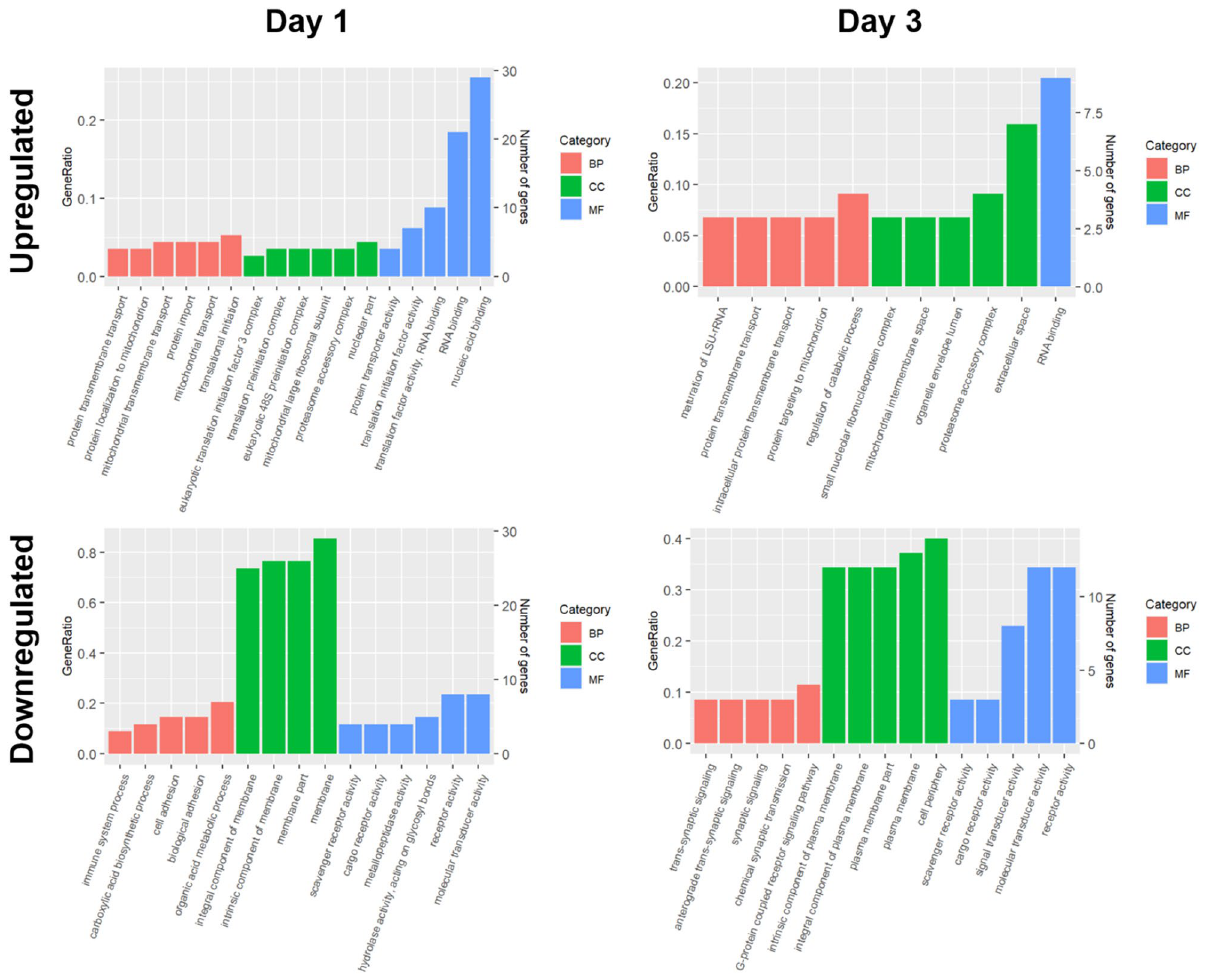
Figure 3. Gene ontology enrichment analysis of differentially expressed genes (DEGs) at day 1 and day 3 of regeneration using DAVID database. Ontology domains comprise biological process (BP), cellular component (CC) and molecular function (MF). The GeneRation is a measure of the gene count divided by the number of genes in the total group of genes assayed that belong to the specific gene